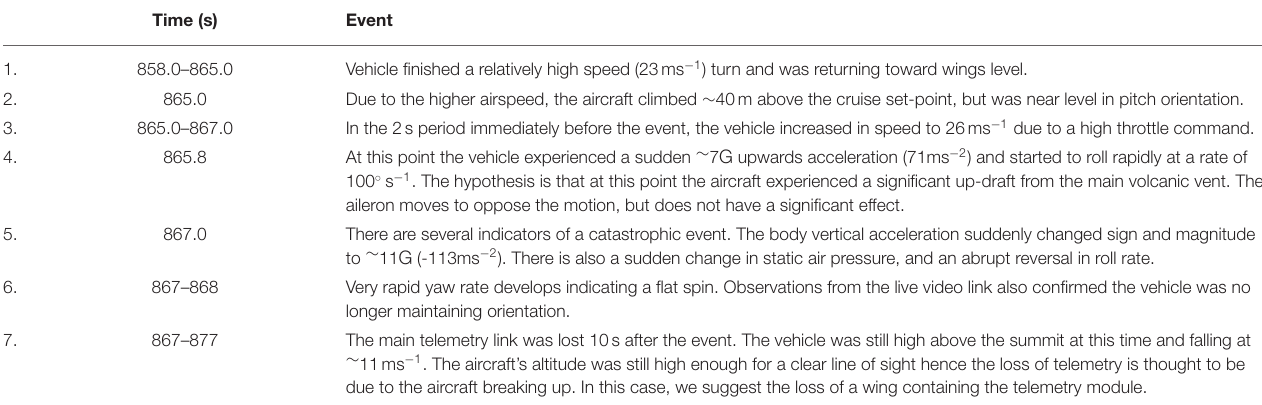
TABLE 3 | Summary of the sequence of events that led to loss of the vehicle during flight C. Time is reported relative to takeoff time and is equivalent to Figure 9